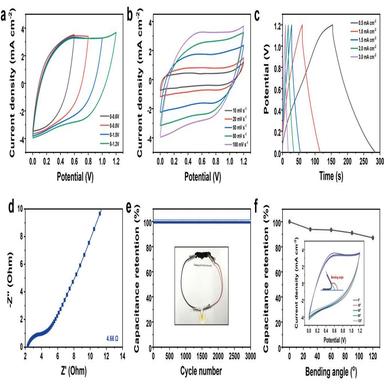
Electrochemical performances of the SSC device. (a) CV curves under various operating potentials. (b) CV curves at scan rates of 10–100 mV s − 1 . (c) GCD curves at current densities of 0.5–3 mA cm− 2 . (d) Nyquist plot. (e) Cycling performance in a potential window of 0–1.2 V, and inset is two SSC devices connected in series to light up the yellow LED indicator. (f) Capacitance retention at different bending angles under 100 mV s − 1 , and the inset shows the CV curves of different bending angles.